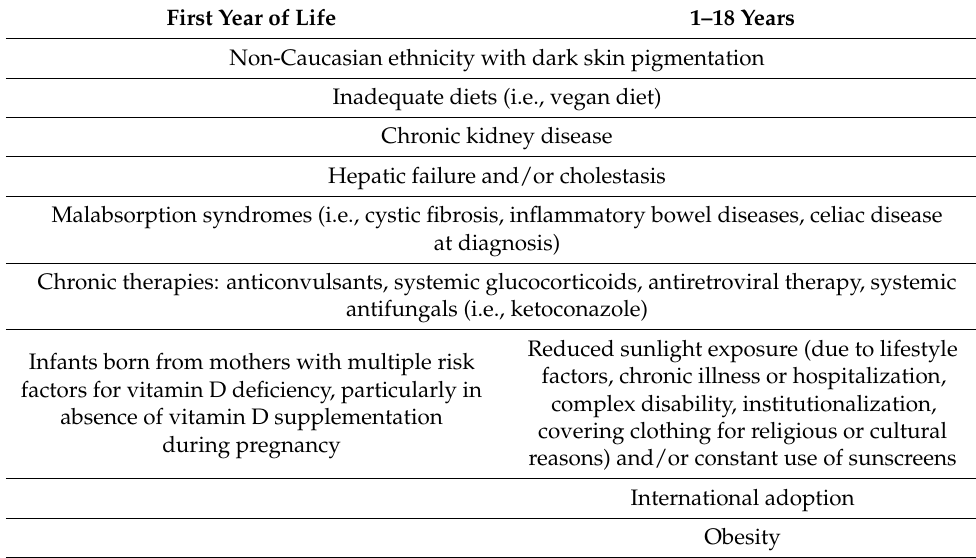
Table 2. Risk factors for vitamin D deficiency in childhood